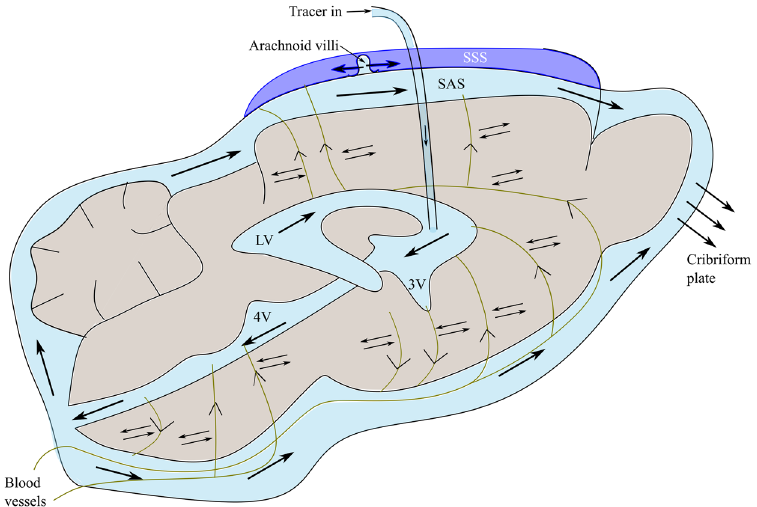
Figure 8. Proposed path for the transport of Gd-albumin tracer (black arrows) infused into the lateral ventricle. Tracer infused into the lateral ventricle reaches the subarachnoid space (SAS) either through the PVS in the parenchyma around it or through the CSF macro circulation in the ventricular system. A portion of the tracer in the SAS drains into the cribriform plate and superior sagittal sinus (SSS), while the rest is transported back into the brain parenchyma through PVS surrounding the blood vessels (green lines) in the brain surface. The PVS surrounding these blood vessels eventually join the macro CSF circulation in the ventricular system. Solute removal from the parenchyma could be facilitated by constant exchange between ISF in the parenchyma and CSF in the PVS by diffusion. Tracer also diffuses from the ventricles and SAS into the adjacent parenchyma (not shown). Arrows along PVS indicate possible directions of transport into and out of the brain. Abbreviations: LV - lateral ventricle, 3 V - third ventricle and 4 V - fourth